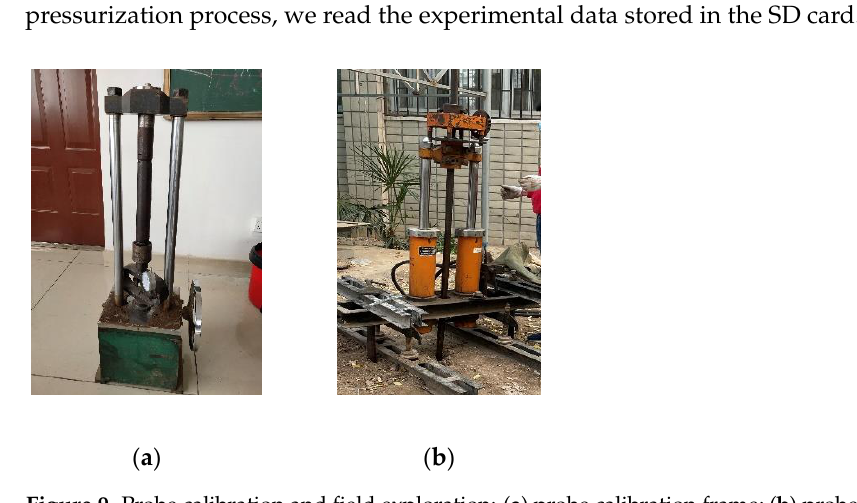
Table 2. Experimental data.